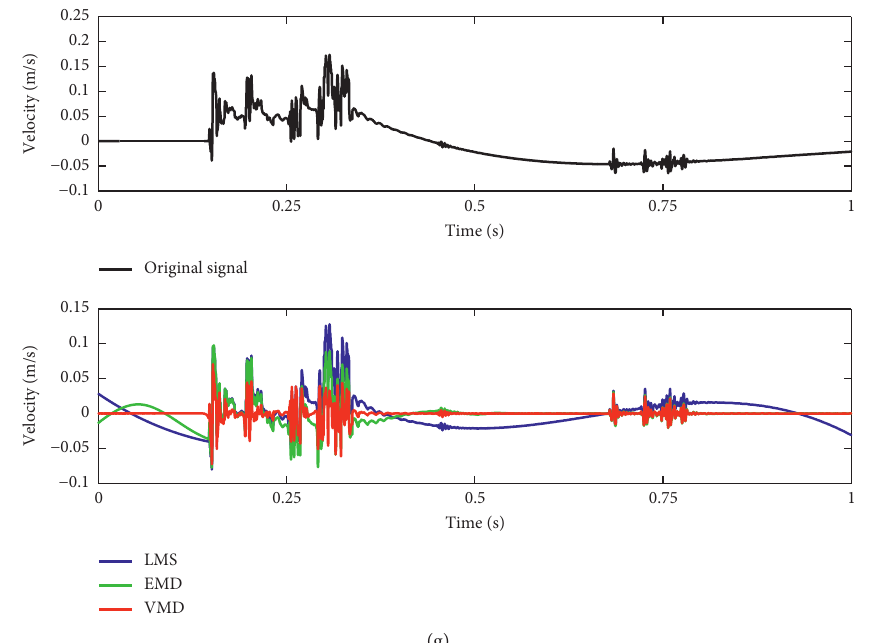
Figure 8: Comparison of baseline calibration results of different methods. (a) The first random blasting signal processing results. (b) The second random blasting signal processing results. (c) The third random blasting signal processing result. (e)–(g) More